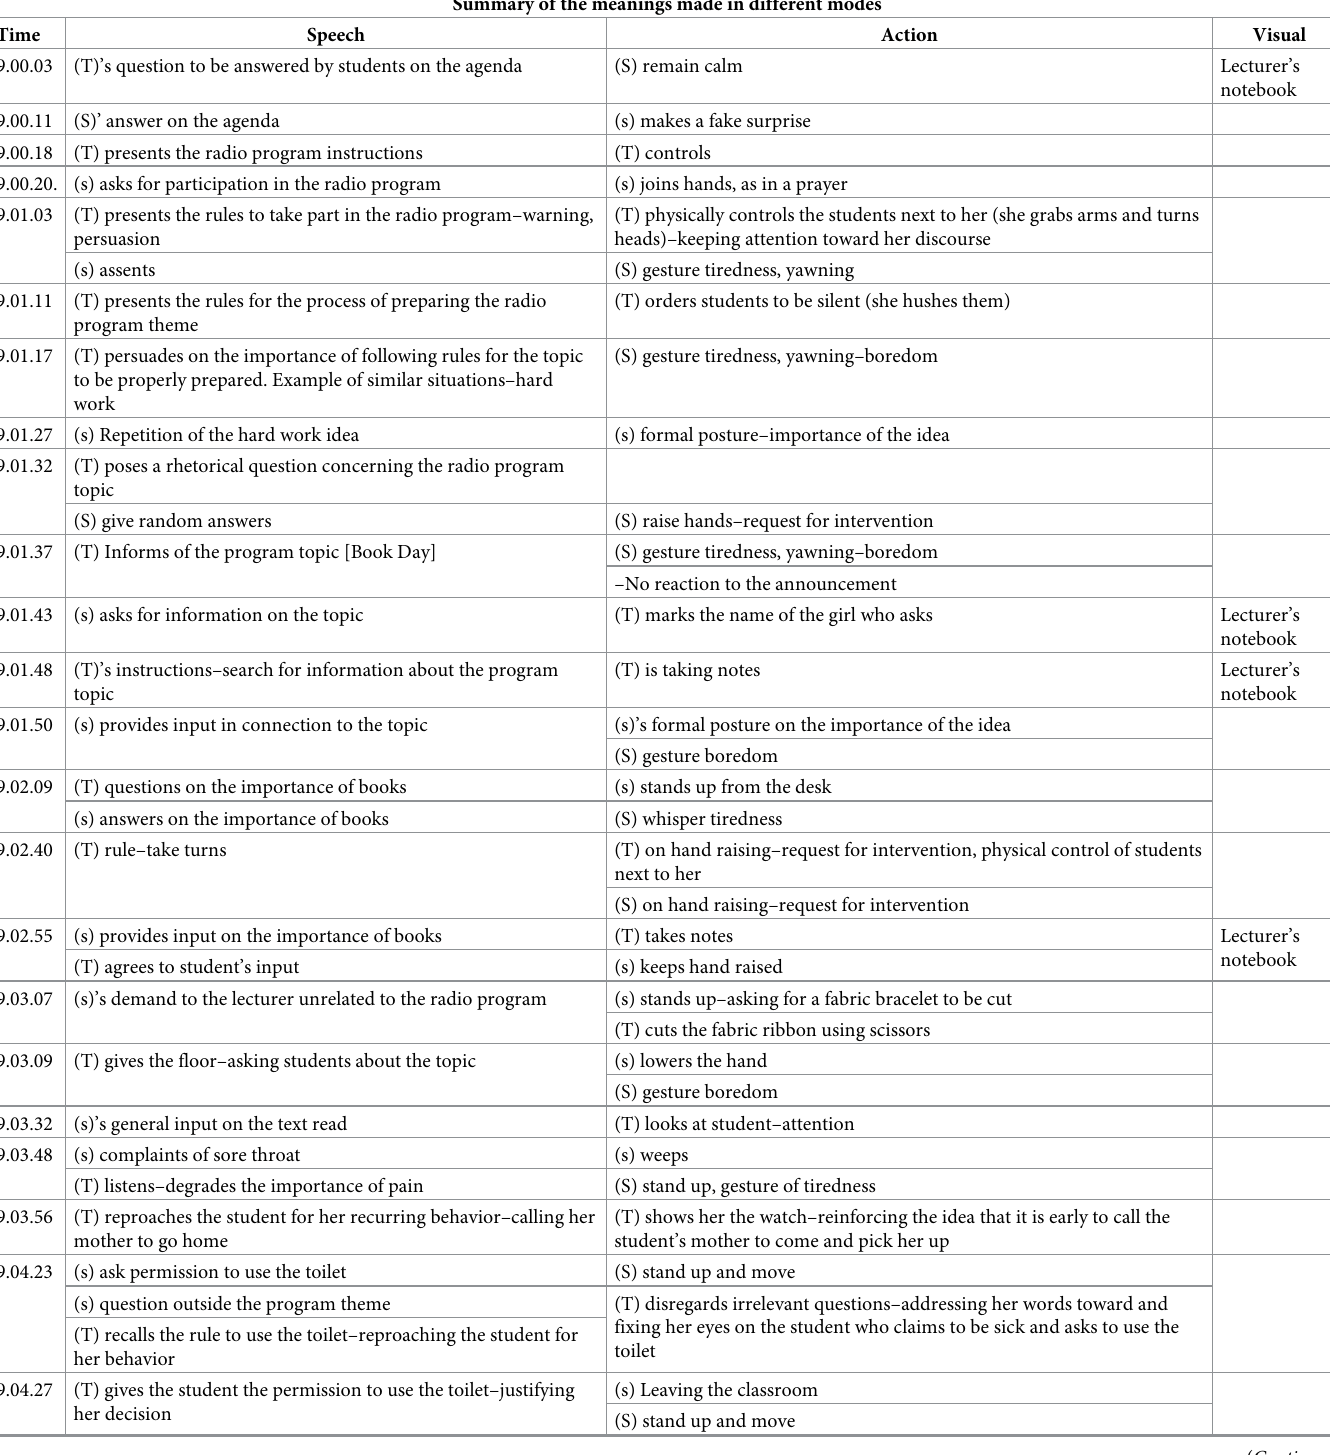
Table 2. The teacher’s and students’ communicative shifts in classroom assembly regarding the radio program